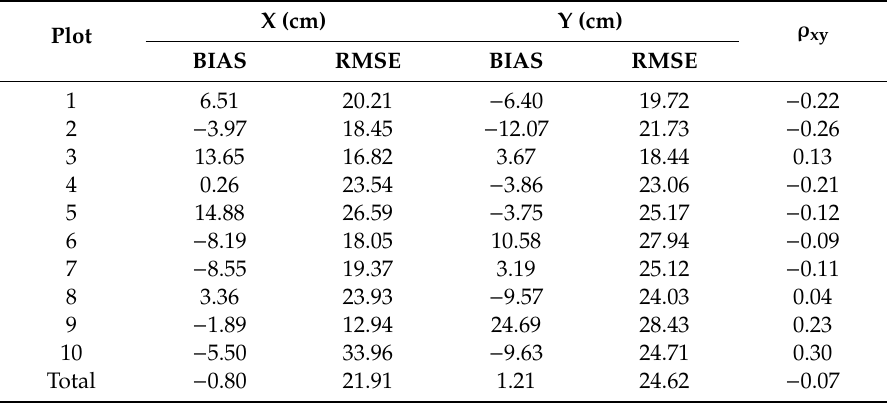
Figure 13. Errors in tree positions measured by the device. Table 4. Accuracy of tree positions in the x- and y-axis directions estimated by the device.